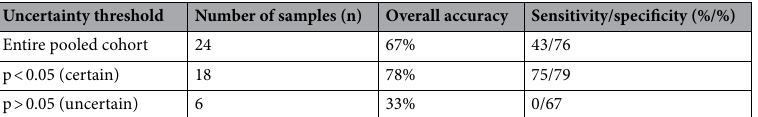
Table 3. Differences in predictive accuracy related to certain versus uncertain sample predictions in the validation set (24 biopsy samples, 7 patients). Shown are the differences in predictive performance of the transductive learning GP model for the entire pooled validation cohort and also when stratifying the sample predictions with high certainty (low p values) versus low certainty (high p values) at various p value